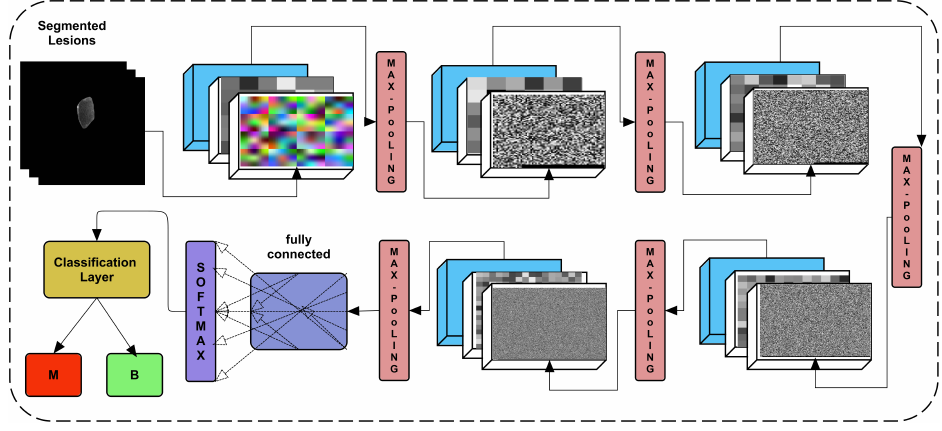
Figure 7. Proposed CNN architecture for